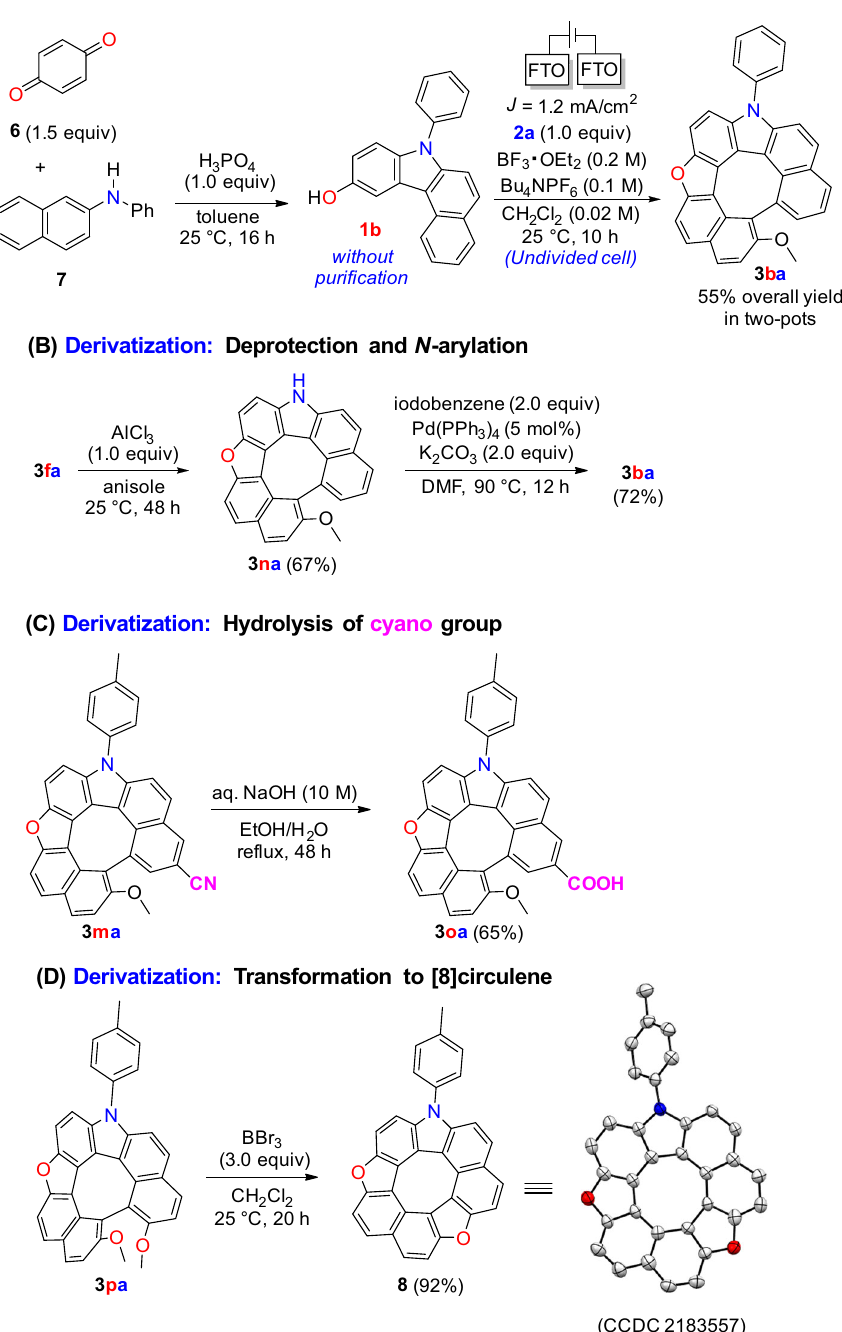
Fig. 3 Two-pot synthesis and derivatization of aza-oxa-dehydro[7]helicenes. A Synthesis of dehydrohelicene 3ba from commercially available substrates. B AlCl 3 - medicated deprotection of Bn- group followed by Pd-catalyzed N -arylation. C Basic hydrolysis of cyano group to afford the corresponding carboxylic acid. D Demethylation of dehydrohelicene 3pa to give the corresponding circulene 8